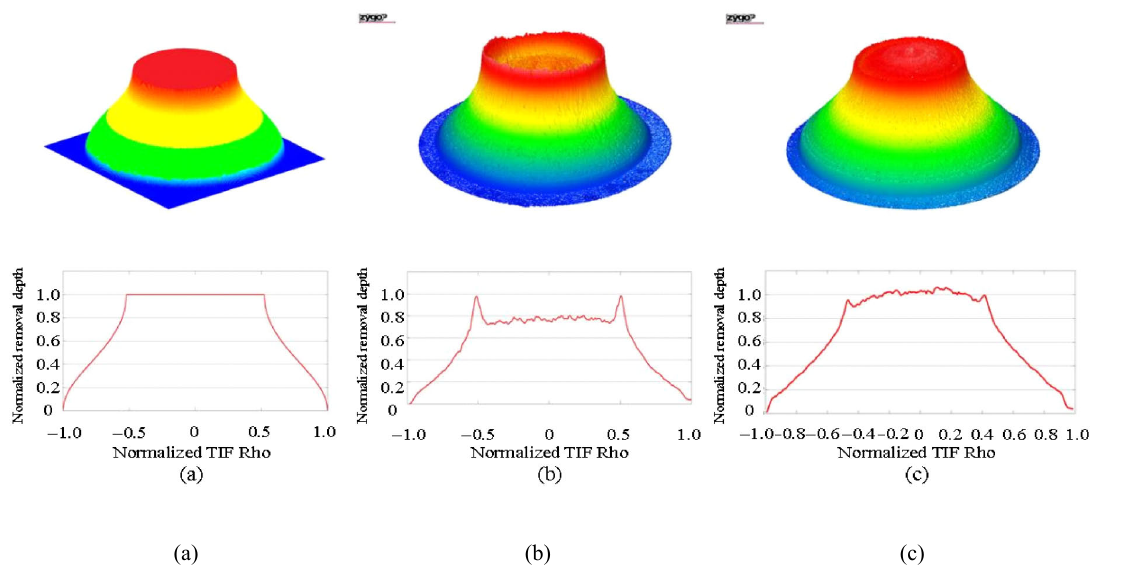
Fig. 8 3D measured TIFs (top) and their normalized radial profiles (bottom) for (a) theoretical, (b) old, and (c) new models. (3) Preston coefficient vs. tool